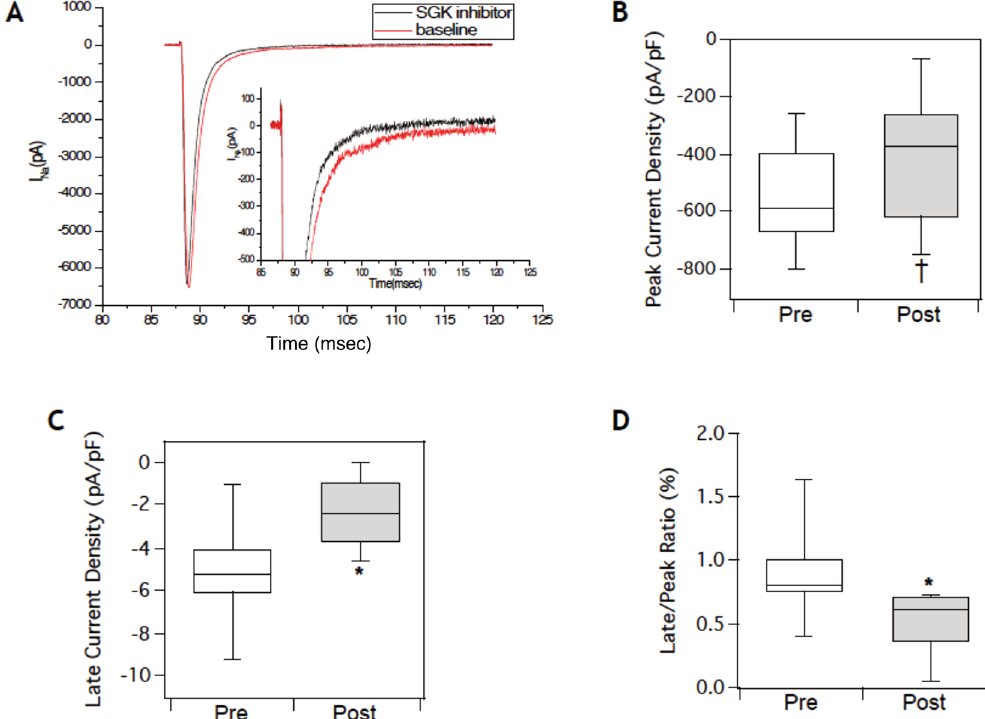
Figure 6. Inhibition of SGK1 in cardiomyocytes selectively reduces the late sodium current I NaL . ( A ) Representative I Na from NRVMs at baseline and after acute treatment with compound 5377051 demonstrates preferential reduction of late current. ( B ) Quantification of the peak current does not demonstrate a significant reduction with administration of the inhibitor (Peak current density: Pre = − 560.1 ± 180 pA/pF versus Post = − 396.1 ± 230.4 pA/pF). ( C ) Selective inhibition of native late sodium current with incubation of the lead compound (Late current density: Pre = 5.12 ± 2.4 pA/pF versus Post = − 2.3 ± 1.5 pA/pF). ( D ) Relative decrease in peak to late current ratio. ( * p-value < 0.05, † p-value = non-significant, n = 6 for all